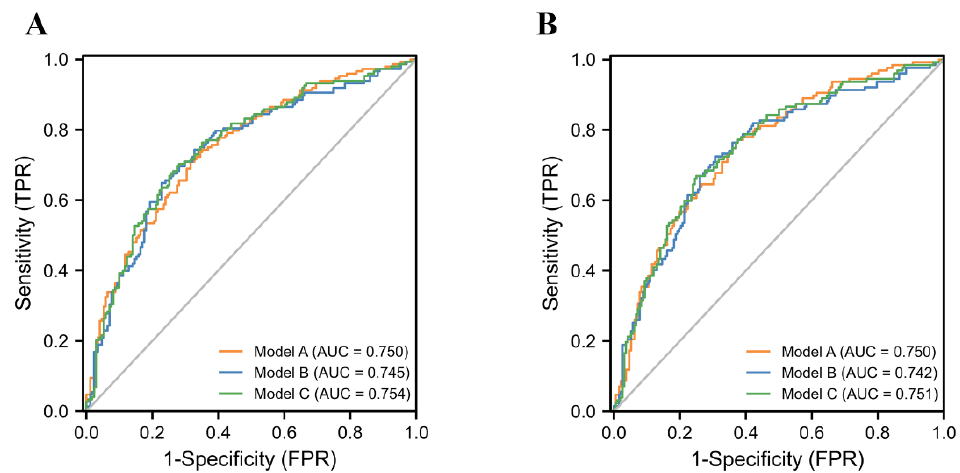
Figure 1. The AUC curves of different models based on SII, MLR, and PIV, respectively, in prostate cancer ( A ) and clinically significant prostate cancer ( B ).